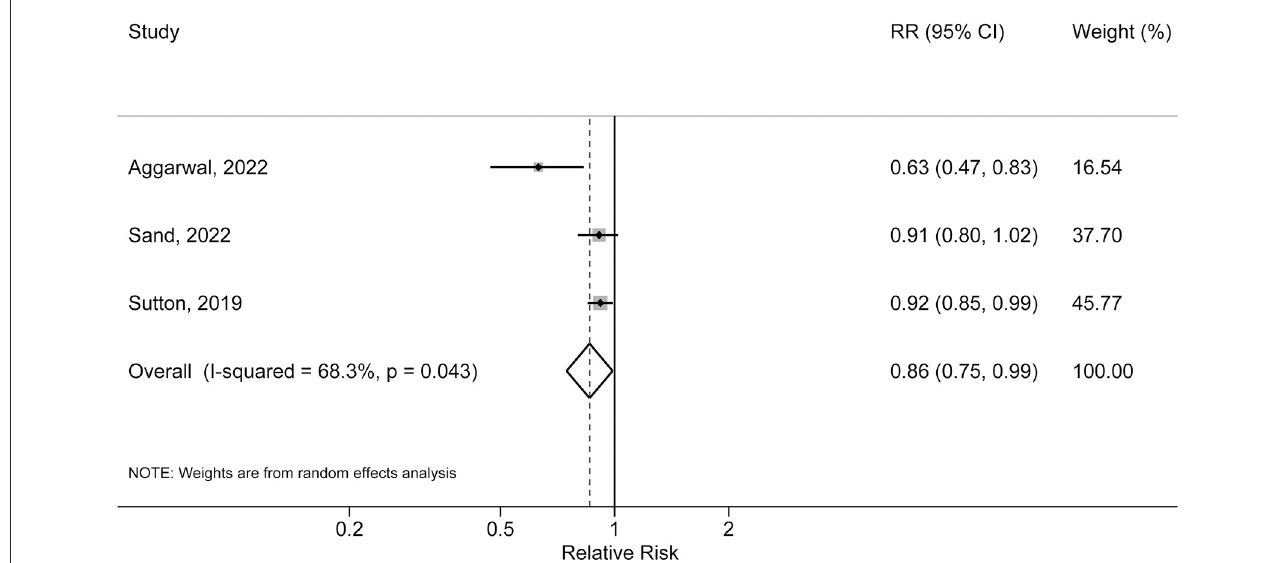
FIGURE3 Forest plot of association between inflammatory bowel disease related medication exposure and risk of Alzheimer’s